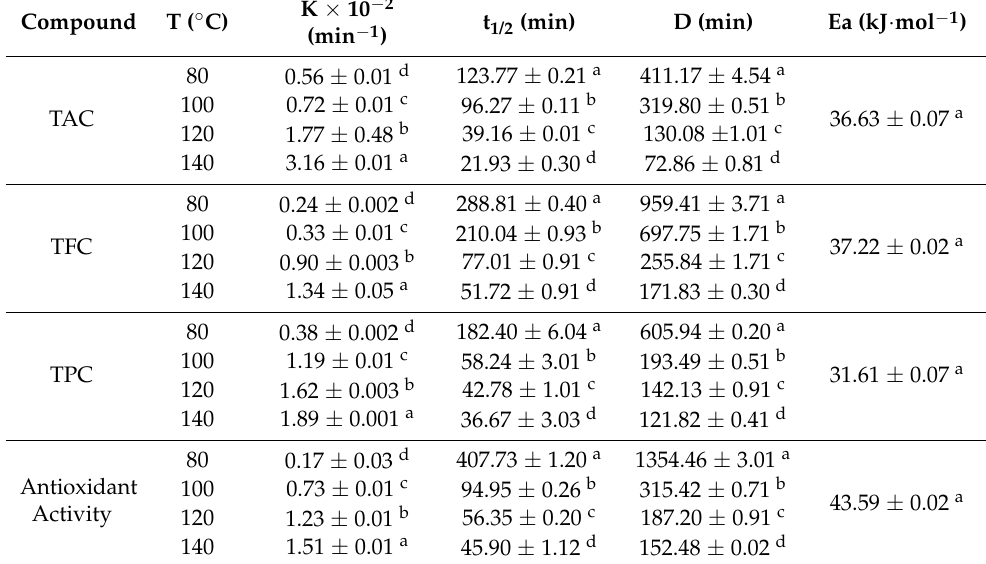
Table 2. The kinetic parameters of thermal degradation of phytochemicals from red grape skin